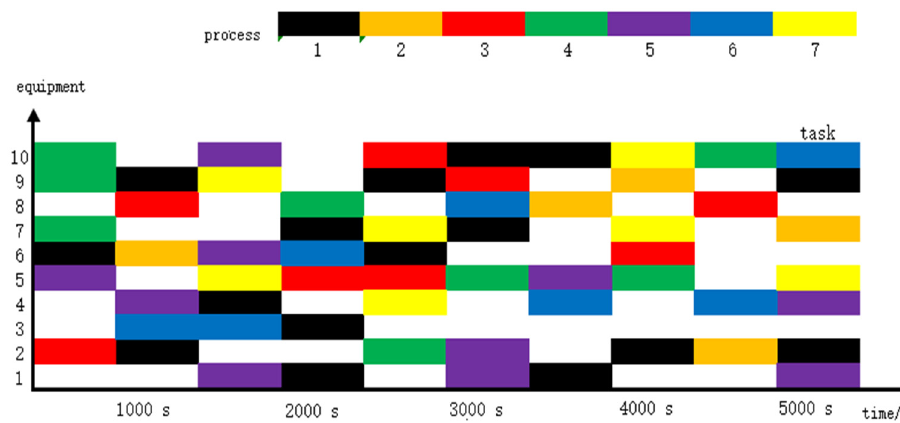
Figure 6. Completion time iteration diagram.